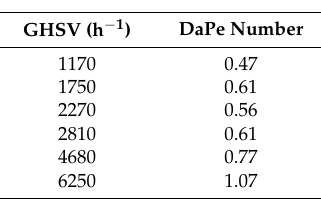
Table 3. The Damkohler and Péclet (DaPe) number of the dual catalyst CMR at different space velocities at 5 bar and 475 ◦ C.